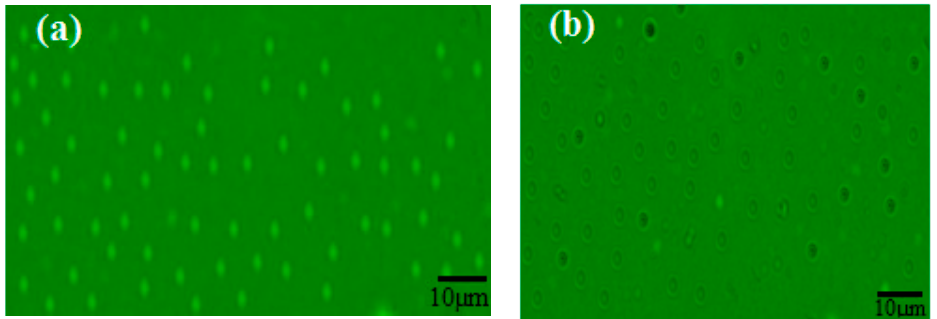
Figure 1. Optical microscope photos of ( a ) PWs emulsion and ( b ) silicon precursor PWs